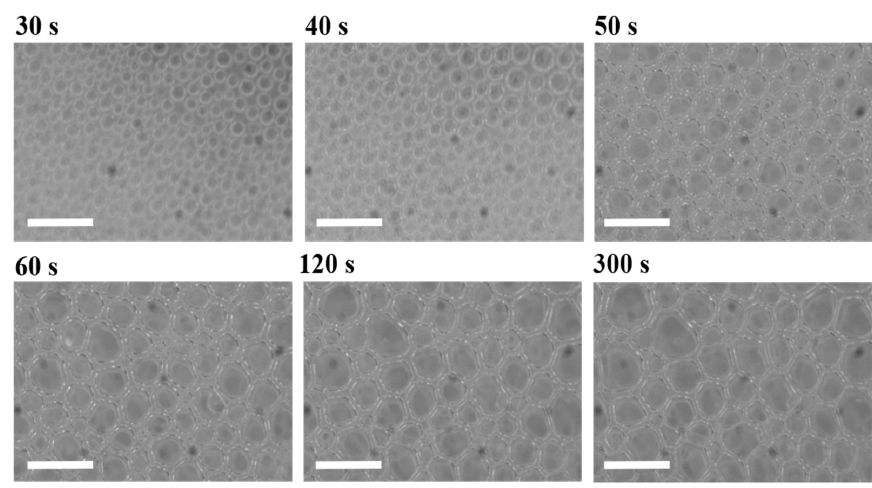
Figure 4. Microphotograms reporting the foaming process of the PU sample obtained at 1000 rpm. Scale bars are 200 µm.